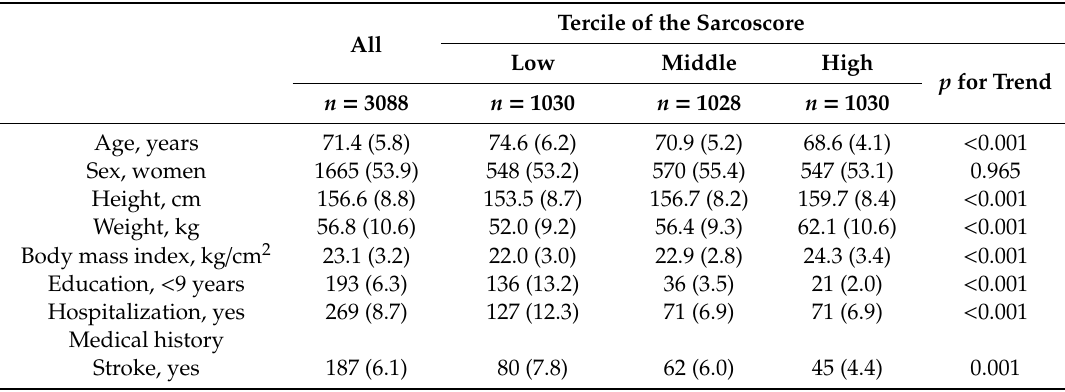
Table 1. Comparison of baseline characteristics according to the tercile of the sarcoscore. All